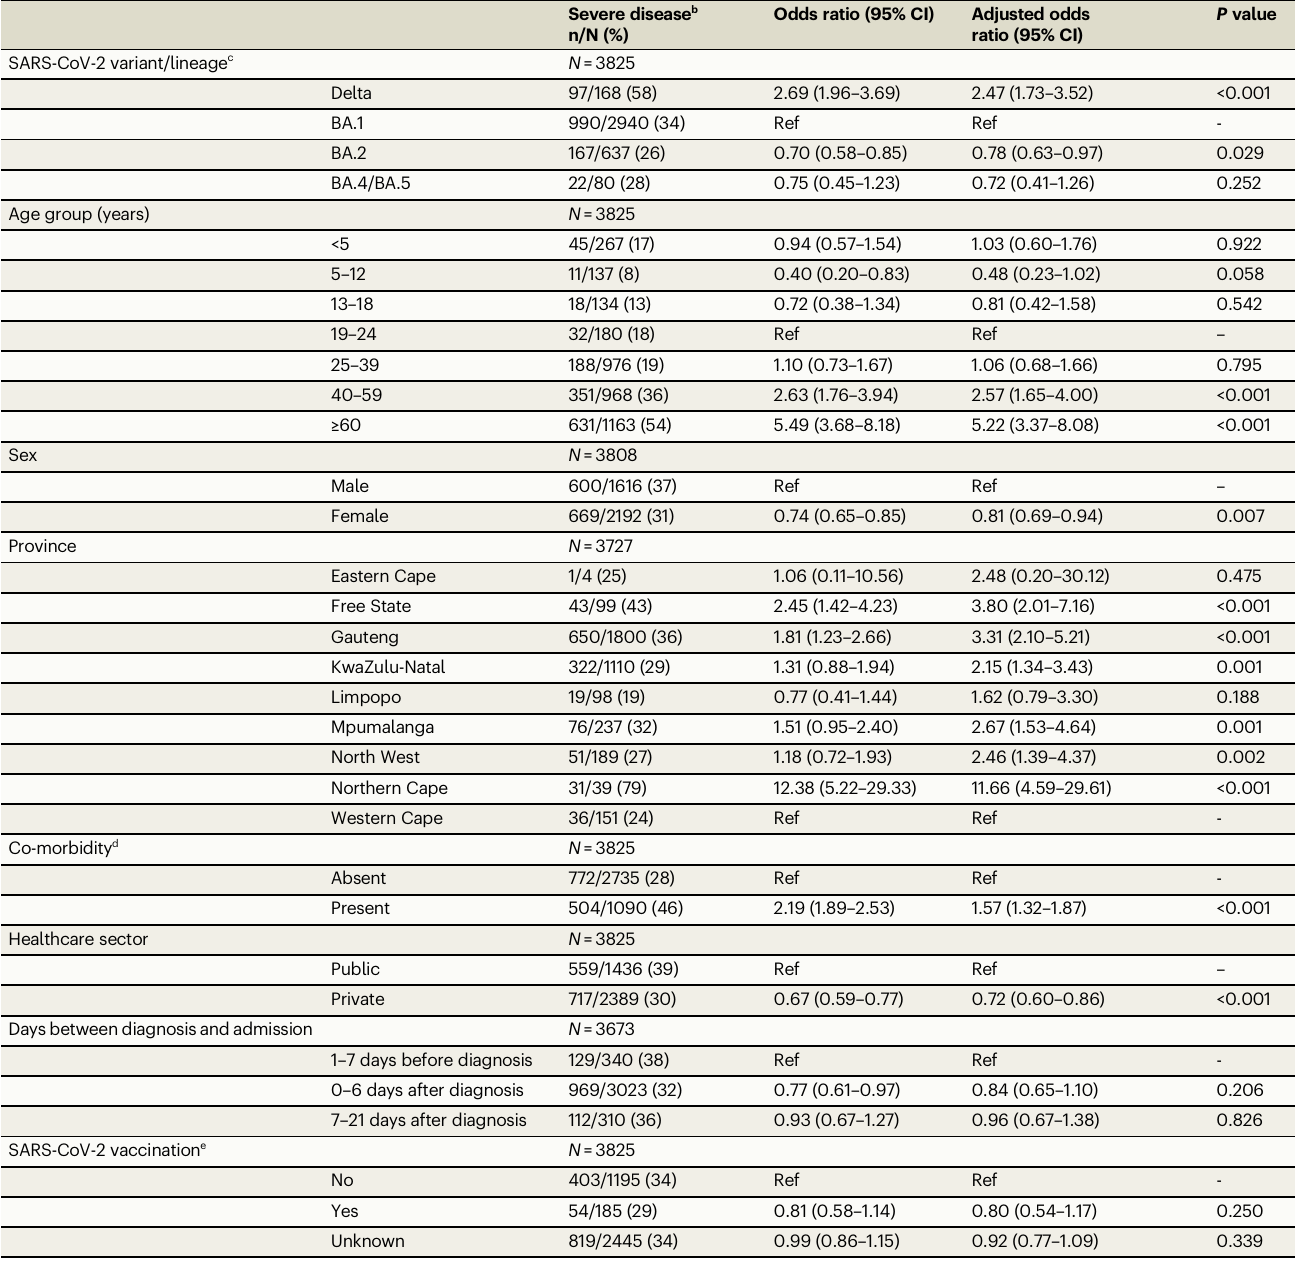
Table 3 | Multivariable logistic regression analysis evaluating the association between SARS-CoV-2 variant/lineage and severe disease among hospitalised individuals, South Africa, 1 October 2021 – 26 April 2022 a ( N =